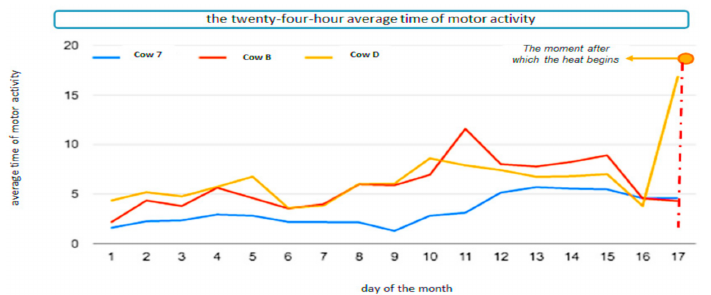
Figure 11. Change in motor activity of cow on